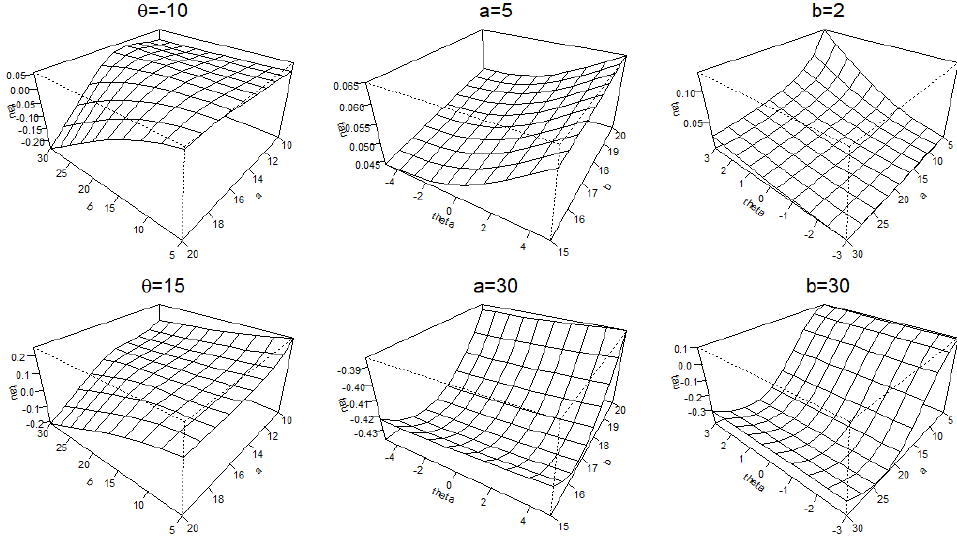
Figure 3. Kendall’s-tau surface plot for the UL-Frank copula for various parameter